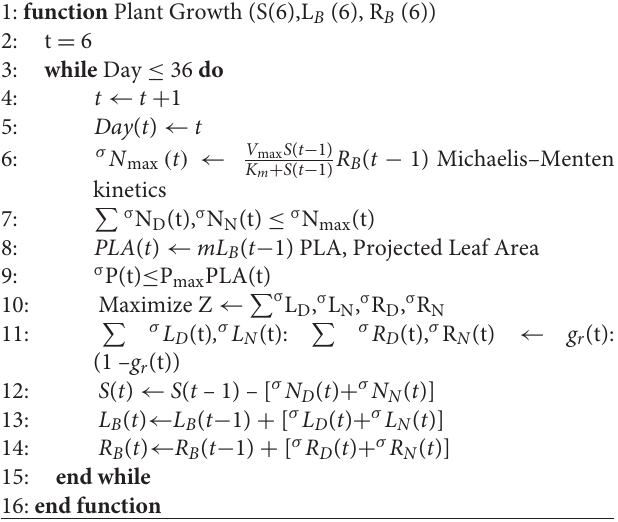
Algorithm 1 Dynamic Flux Balance Analysis (dFBA) for Plant